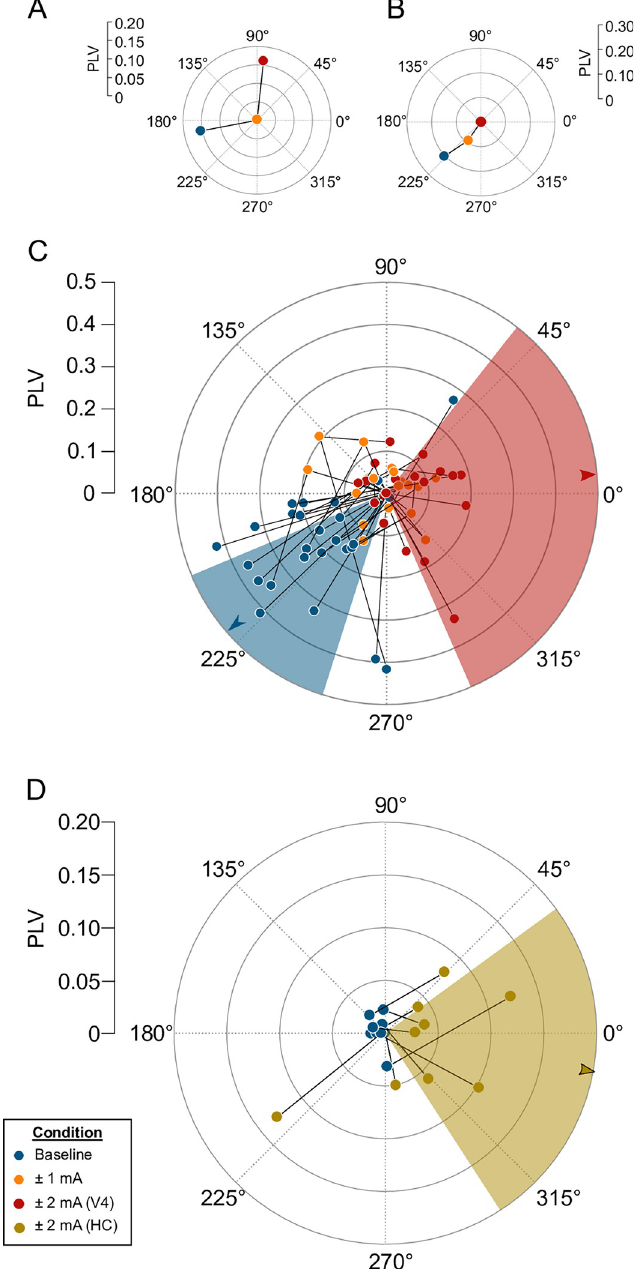
Fig 3. tACS reduces entrainment, then reinstates it at a different phase, as the stimulation amplitude increases. (A–C) Polar vectors indicating the phase and strength of V4 neurons’ entrainment (as in Fig 3). The dots indicate baseline conditions (blue), followed by ± 1 mA tACS (orange) and ± 2 mA tACS (red). Shading indicates the median and 95% CI of the phase preference during baseline (blue) and ± 2 mA tACS (red). Panels A and B show an example trajectory for one neuron exhibiting reinstated entrainment (A) and another undergoing progressive decreases in entrainment (B). Panel C shows population data from 27 neurons with significant changes in PLV at either amplitude. (D) Data from N = 9 hippocampal neurons during baseline (blue dot) and ± 2 mA tACS (olive), plotted as in panel A. Note that ± 2 mA tACS produces an electrical field within the hippocampus that is 3 times weaker than the ± 1 mA condition for V4. See S1 Data for numeric values. PLV, phase-locking value; tACS, transcranial alternating current